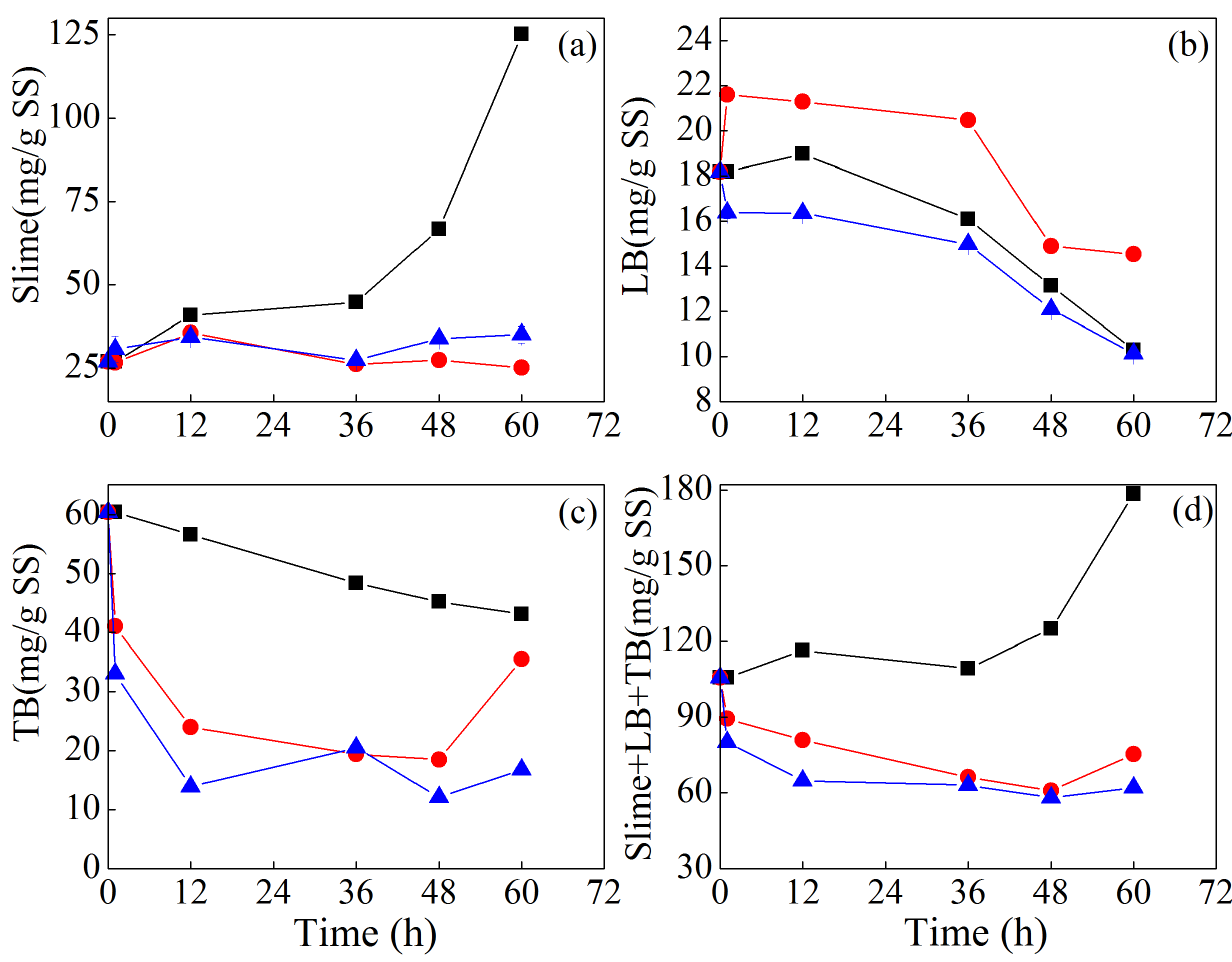
Figure 5. Variation of total EPS content in Slime (a), LB (b), TB (c) and Slime + LB + TB (d) layers during sludge bioleaching process. ( & CK1, # CK2, g A.t + A.f).